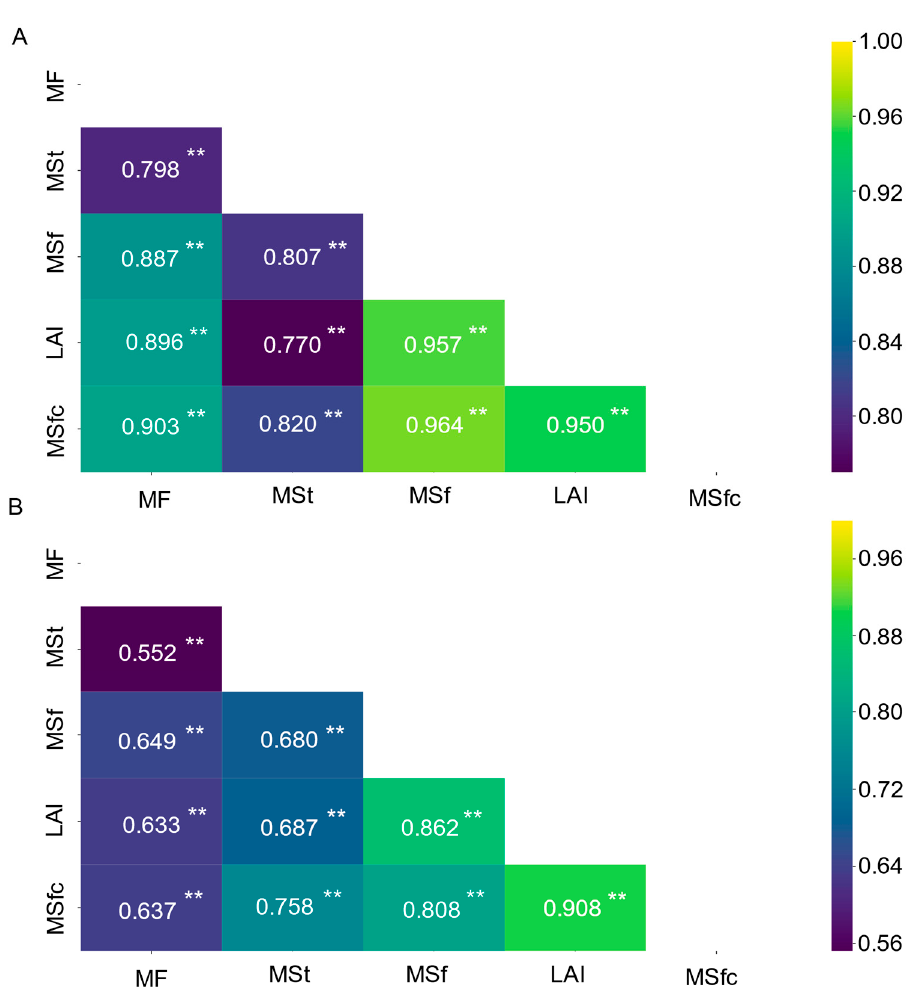
Figure 6. SAFER estimated fresh mass (MF) and in situ pasture variables correlogram (total dry mass: MSt; dry leaf mass: MSf; leaf and stem dry mass: MSfc; and leaf area index: LAI). ( A ) SILV; ( B ) INT. ** = Spearman significant correlation at 0.01.